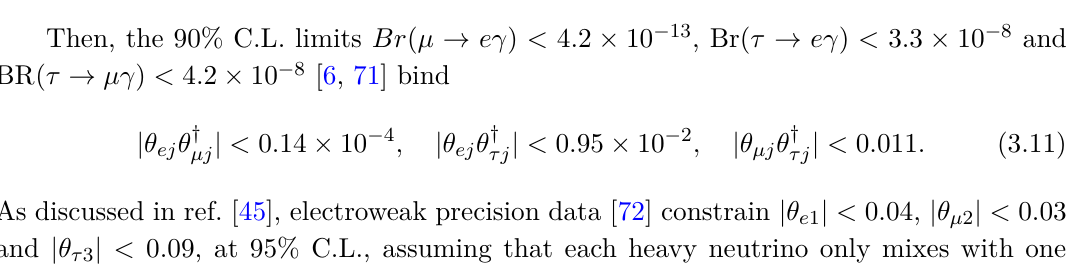
Figure 2 . Z penguins diagrams that contribute to the Z → T − I and T − III allow to mix light and heavy Majorana